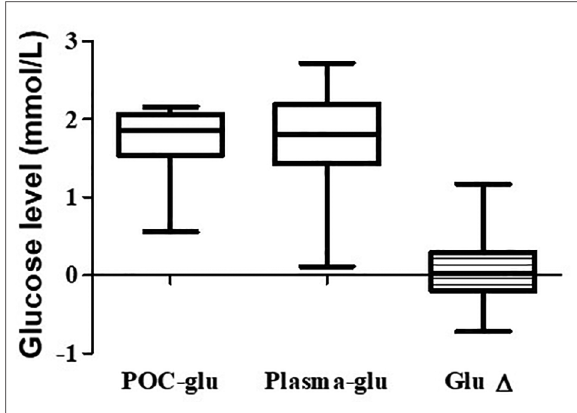
FIGURE 2 Comparison of POC and the plasma glucose levels. The median, fi rst, and third quartiles are shown in the graph. The median difference between the POC and the plasma glucose is 0.05 mmol/L. POC,